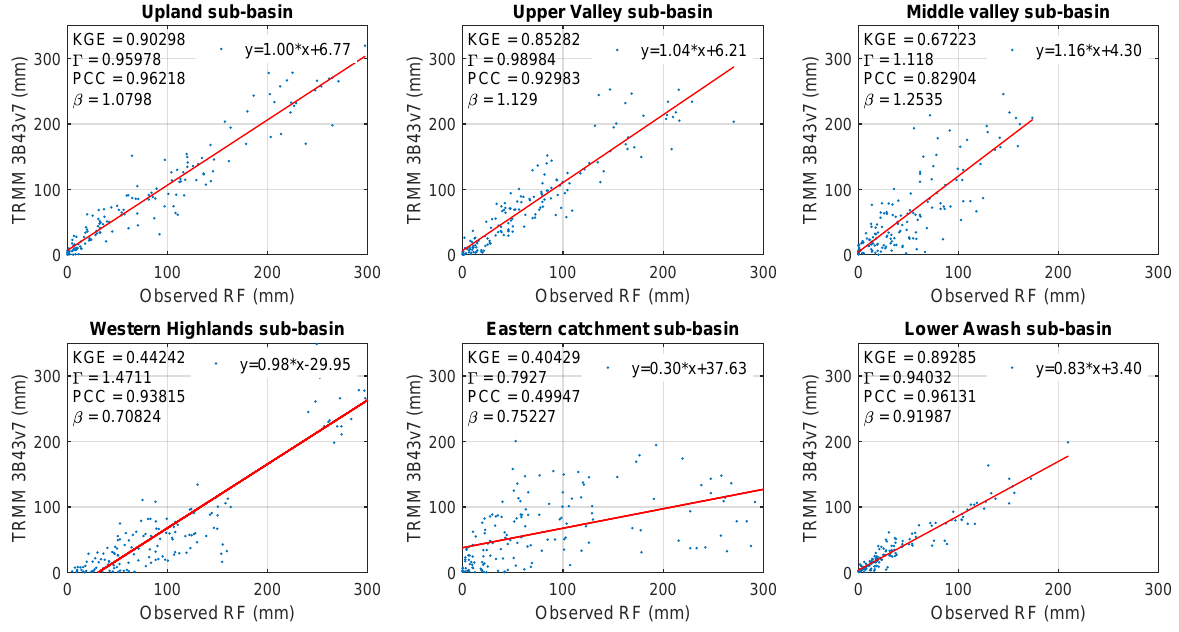
Figure A1. Comparison of TRMM 3B43v7 with GROS.